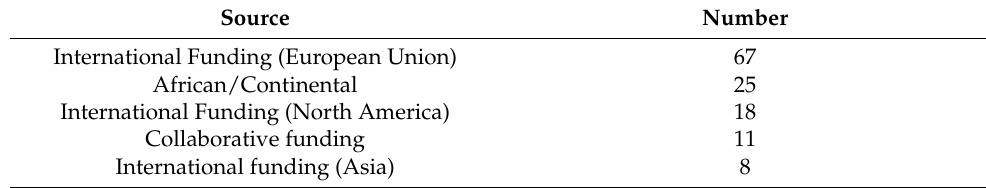
Table A4. Funding